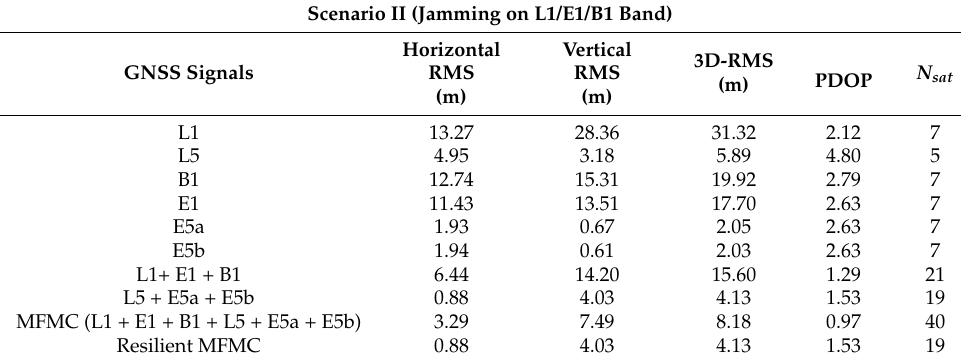
Table 5. Positioning accuracy of Scenario II with different signal combinations.